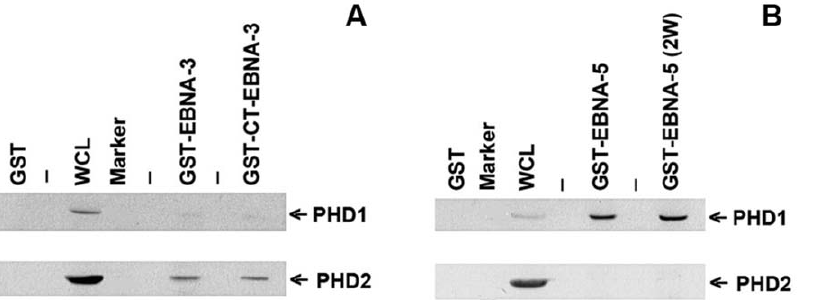
Figure 3. PHDs 1 and 2 bind to EBNA-5 and EBNA-3, respectively. A – Western blotting following the GST pulldown assay from lymphoblastoid cell lysates. PHD2 and a small portion of PHD1 were precipitated on the beads with GST-EBNA-3 from cell lysate. Positive control shows 15% the crude lysate. B – Western blotting following the GST pulldown assay from LCL lysates. PHD1 was precipitated on the support with immobilized GST-EBNA-5 protein from the lymphoblastoid cell lysate. Positive control shows 15% of the crude